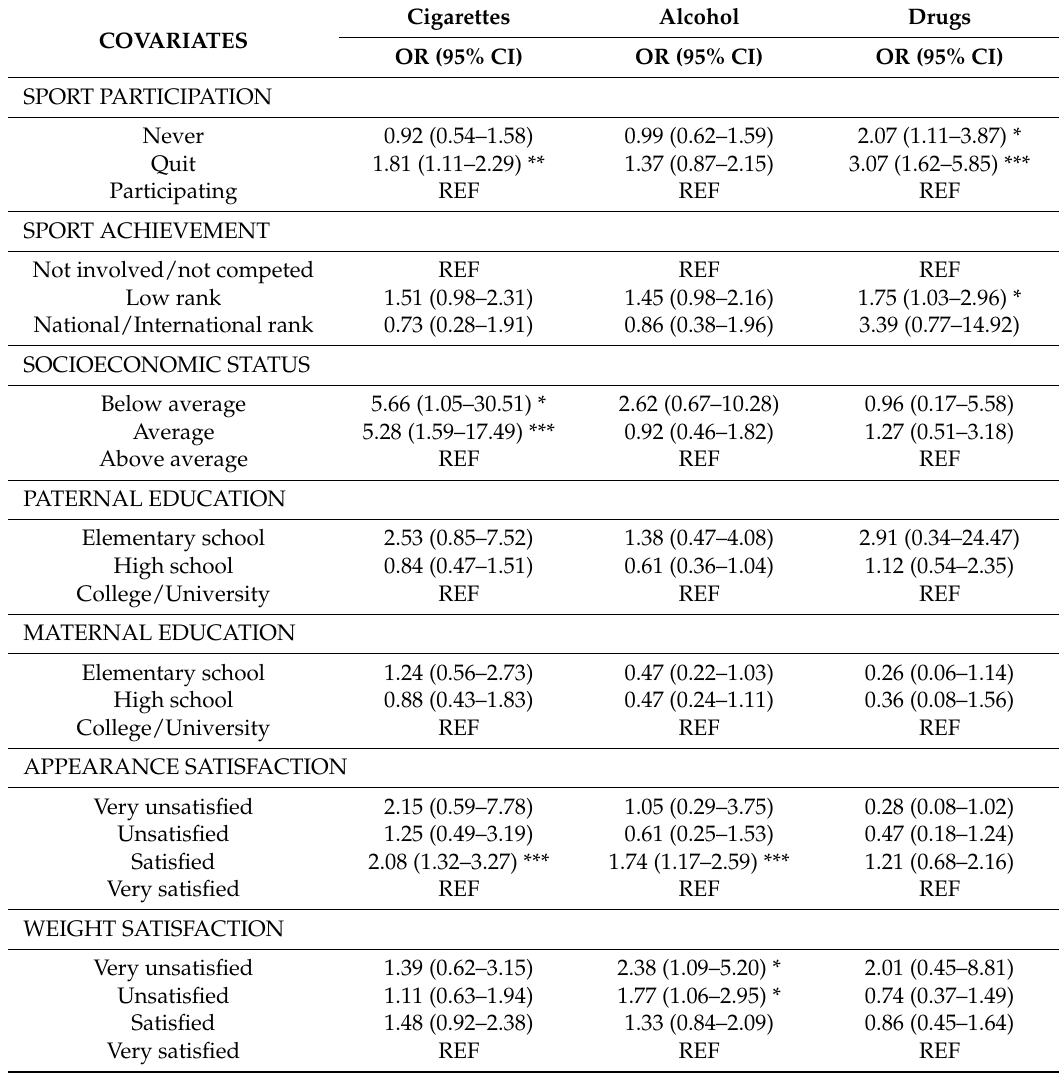
Table 4. Logistic regression calculations for Bosniak